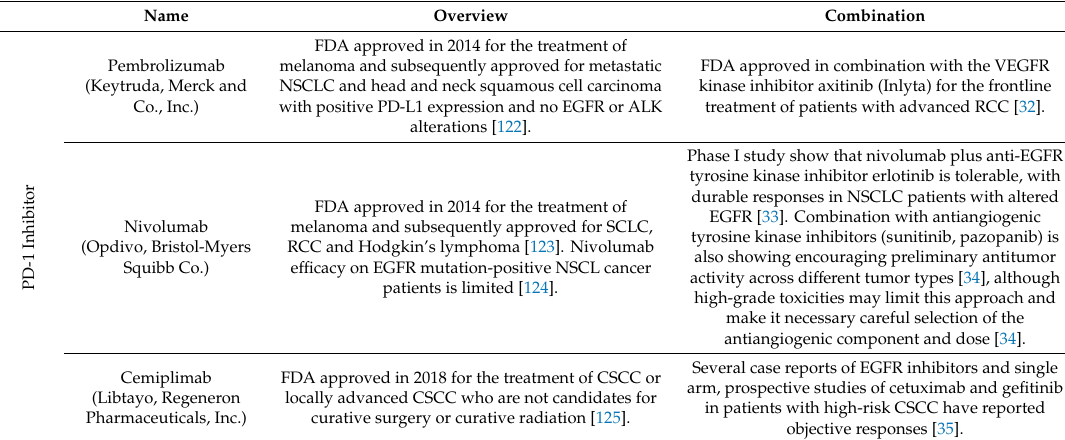
Table 4. Approved PD-1 / PD-L1 check-point inhibitors and combination studies with kinase inhibitors.